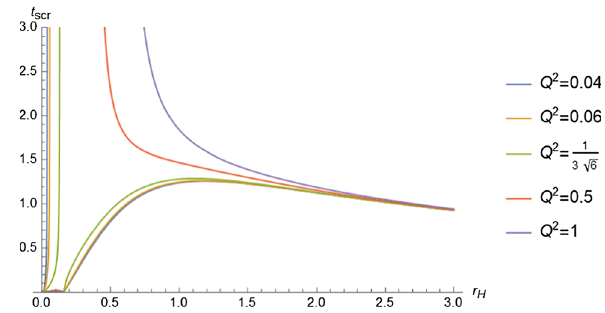
Fig. 13 The scrambling time as a function for the radius at Q 2 = , 0 . 5 , 1 √ 0 . 04 , 0 . 06 , 1 3 6